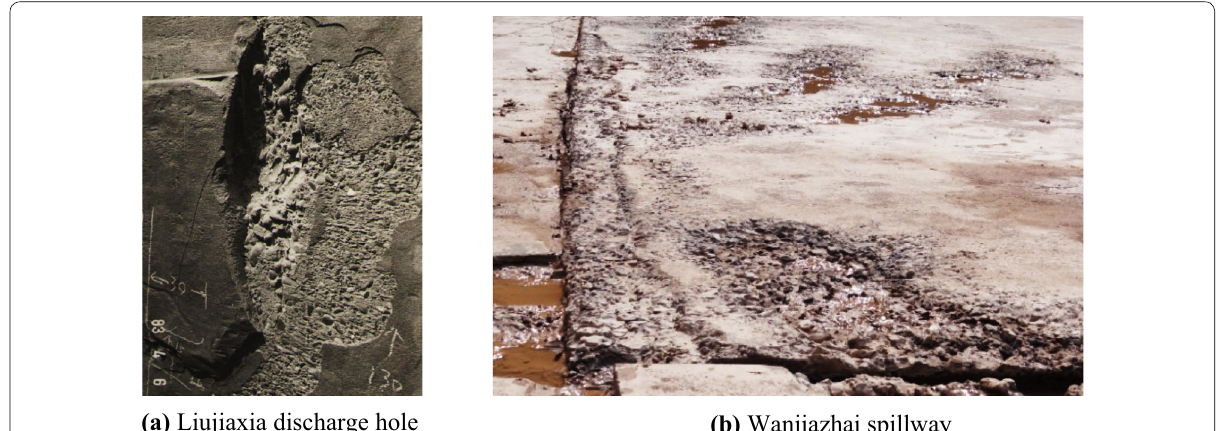
Fig. 1 Erosion of discharge structure in the Yellow